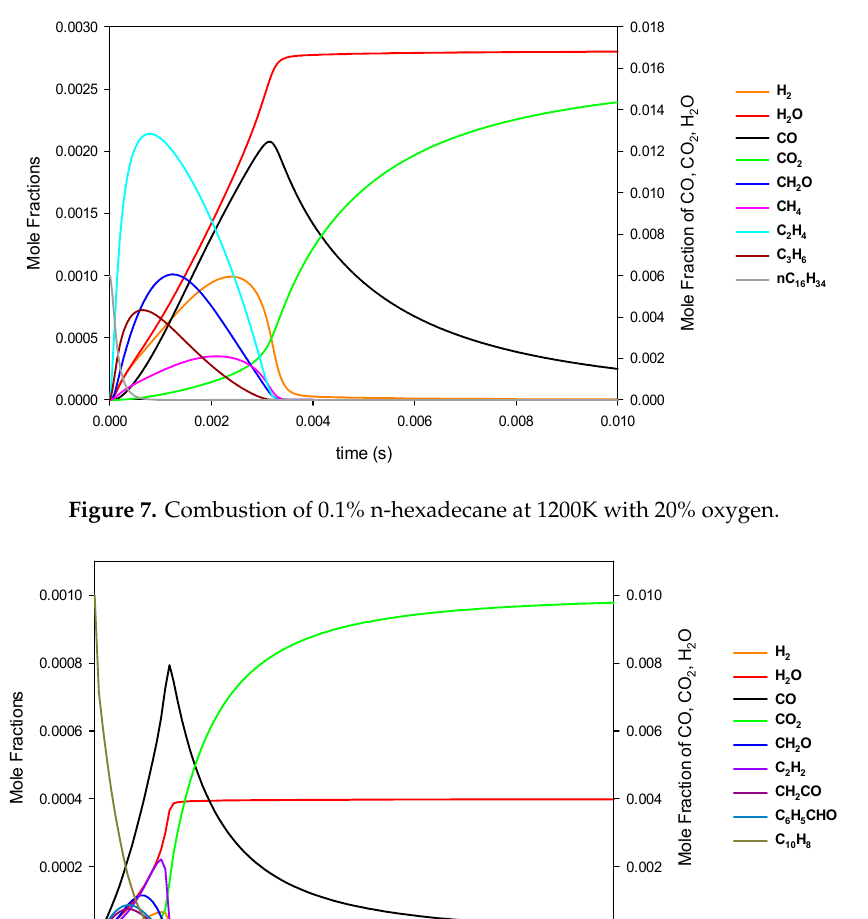
Figure 7. Combustion of 0.1% n-hexadecane at 1200K with 20% oxygen.